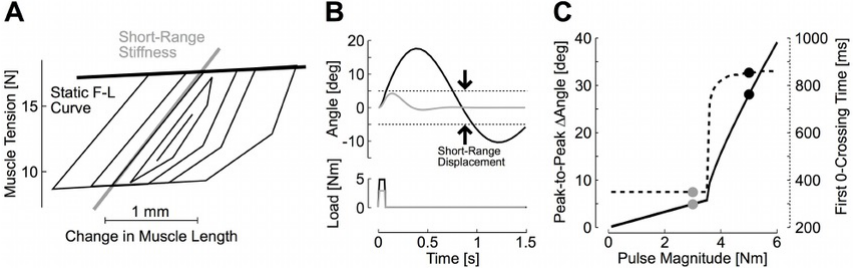
Fig. 11 Timing chart of left arm motion correlation parameters.